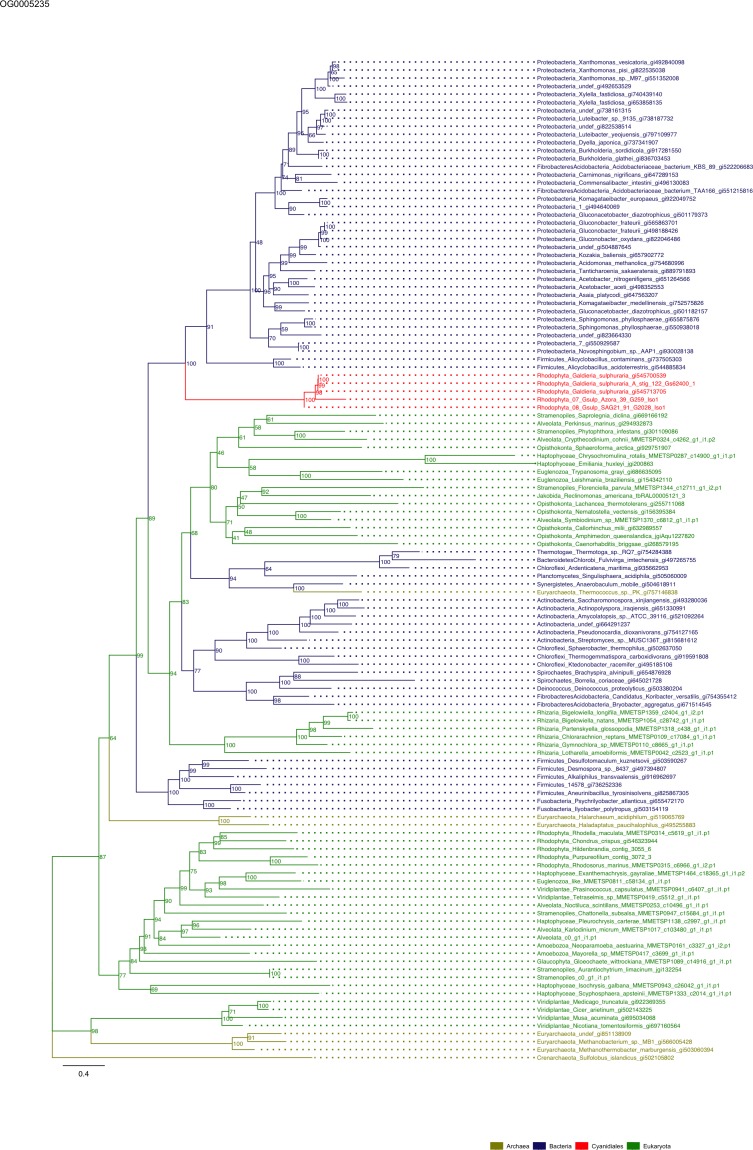
Sequence tree of orthogroup OG0005235.The tree is based on amino acid sequences. Archaea (yellow), Bacteria (blue), Cyanidiales (red), Eukaryotes including other red algae (green). Branches containing Cyanidiales sequences are highlited in red.